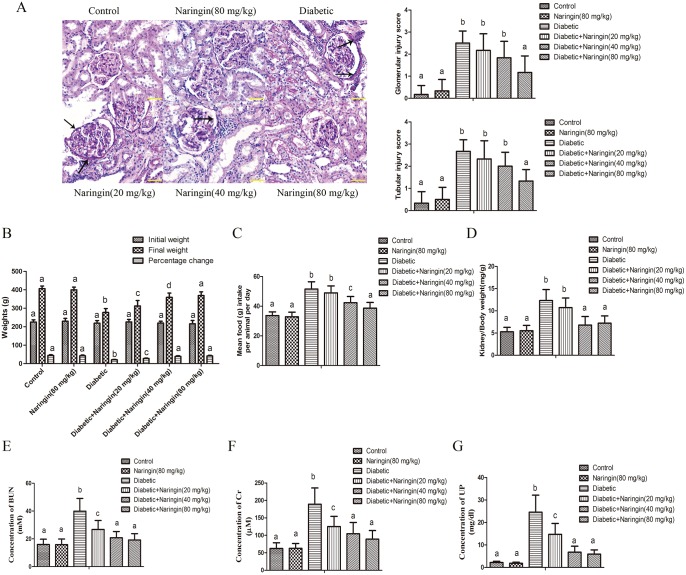
Naringin mitigated changes of pathomorphology and kidney injury biochemical indexes.(A) The pathological changes of renal tissues were investigated by PAS staining(400×). The glomerular injury and tubular injury scores were shown. (B) Body weight and percentage change in weight of rats. (C) Food intake per rat per day. (D) The ratios of kidney weight/ body weight were calculated. The concentrations of BUN (E), Cr(F), and UP(G) were detected. Results represent three independent experiments. Data were expressed as means ± SD, n = 6.a-d Means with different superscripts are significantly different (P< 0.05).